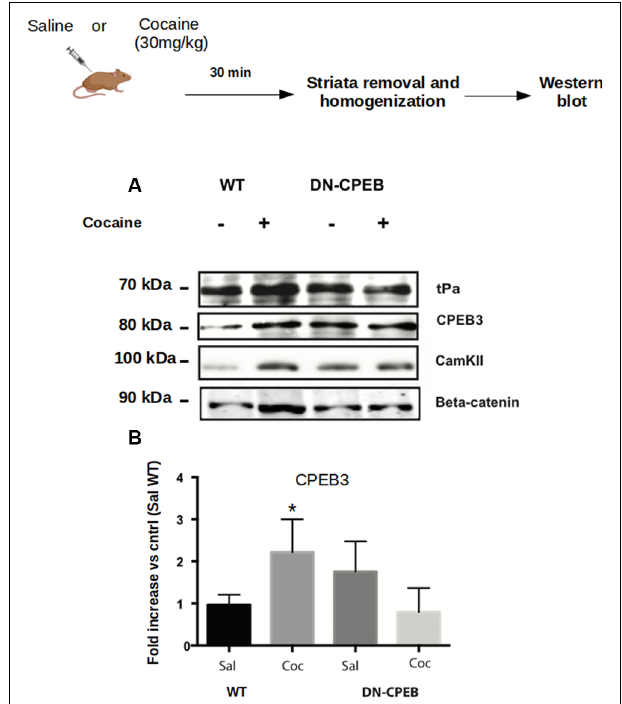
FIGURE 5 | CPEB1 and CPEB3 target expression are impaired in DN-CPEBs mice. (A) Homogenates from WT and DN-CPEB mice ( n = 4) treated with acute cocaine (30 mg/kg) were probed for the known target of CPEB1 and CPEB3. (B) Cocaine-induced CPEB1 and CPEB3 targets expression increase found in WT ( p < 0.05) mice is abolished in DN-CPEB mice. (B) Quantification of CPEB3 in WT and DN-CPEB mice (Saline vs. Cocaine * p > 0.05). * p <